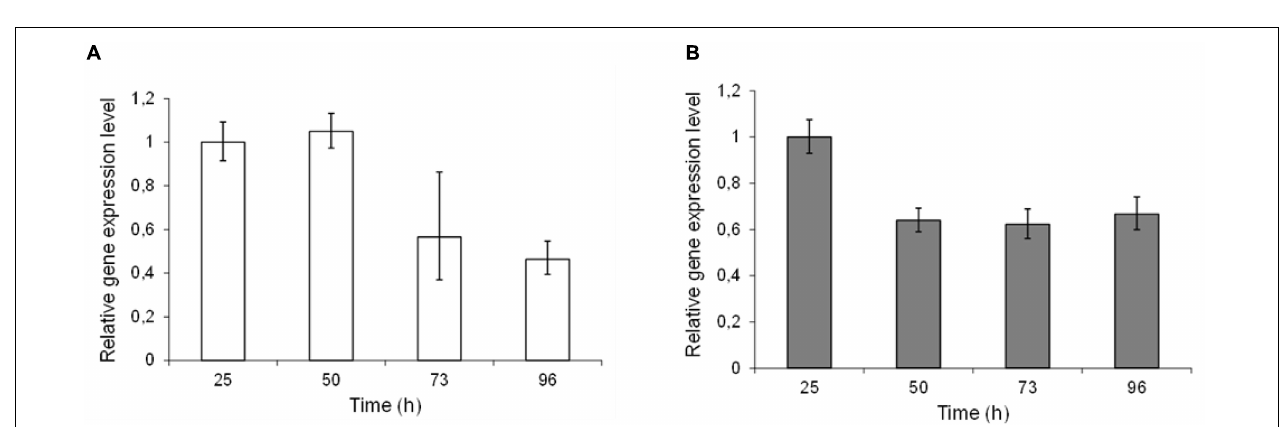
FIGURE 2 | Relative expression levels of epimerase genes in RB11/algE1syn (A) and RB11/algE4syn (B) during cultivation in HCD medium with feeding solution composed of glucose (60%) and methanol (10% of glucose). Samples for DNA isolation were taken during the fermentation at 27, 50, 73, and 96 h after inoculation. For each strain the expression level in sample 1 is set as 1. Quantifications were performed in triplicate and standard deviations from the mean are indicated by error bars.